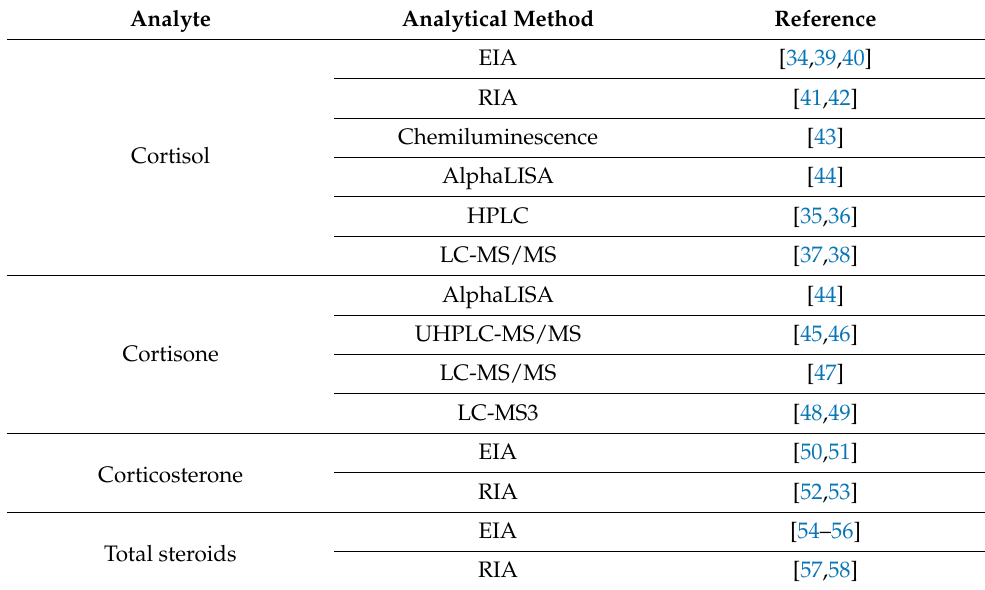
Table 2. Main methods used for glucocorticoid